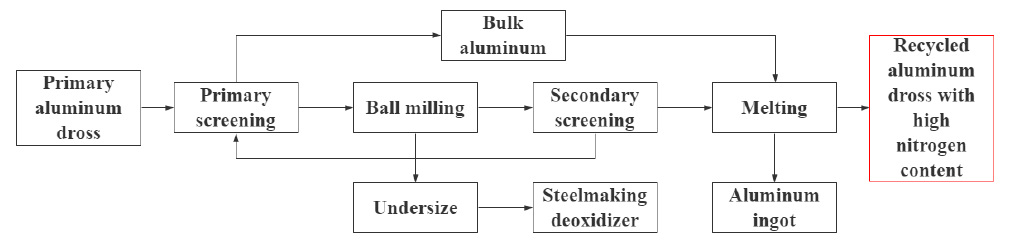
Figure 1. Production flow chart of aluminum dross.